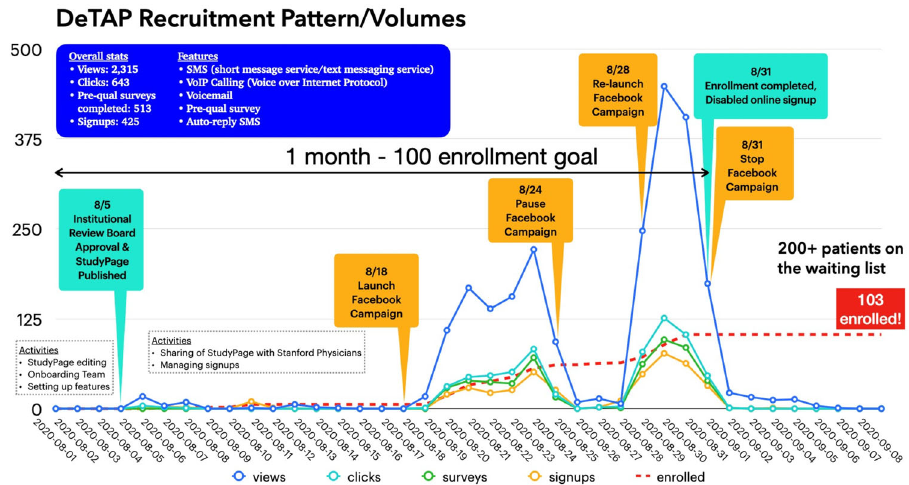
Fig. 2 DeTAP trial recruitment volumes over time with traditional and virtual, social media-based recruitment. IRB Institutional Review Board, FB facebook, SMS short message service (text messaging service), VoIP Voice over internet protocol (Figure provided by StudyPages, Yuzu Labs PBC). Table 3. Key survey outcomes at baseline and study end.